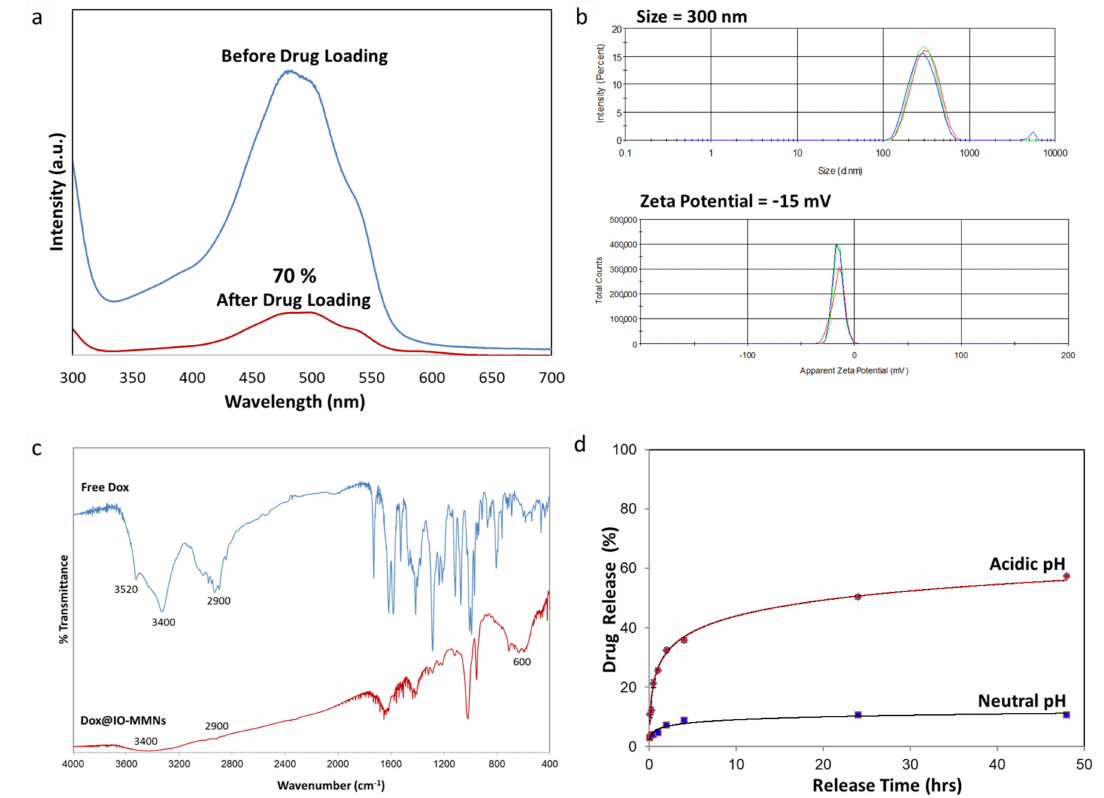
Figure 4. Drug loading and release of Dox@IO-MMNs. ( a ) UV-vis spectroscopy of IO-MMN aliquot before and after Dox loading; ( b ) size and zeta potential distribution graphs showing hydrodynamic sizes (D H = 290 nm) and zeta potential ( ξ = − 35 mV) of Dox@IO-MMNs dispersed in water; ( c ) FTIR spectra for free Dox (above) and Dox@IO-MMNs (below) showing the peaks associated with Dox and hence its successful loading; ( d ) Dox release profiles of Dox@IO-MMNs at two different pH values, indicating the pH-dependent release of Dox at acidic (4.5) but not at physiological (7.4)